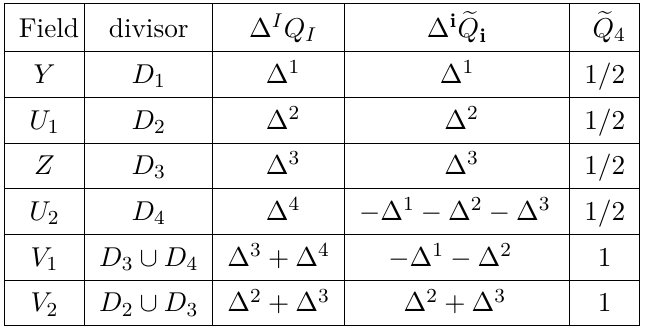
Table 1 . Charge assignments for the L a,b,c family of toric quivers. These have d = 4 global symmetries, and include the Y p,q family (given by Y p,q = L p + q,p − q,p ), which in turn includes Z 2 p orbifolds of N = 4 SYM (given by Y p,p ), as well as the conifold theory and its Z p orbifolds (given by Y p, 0 ). The table displays the six different types of fields, where we are using the notation of [52]; the divisors in the Calabi-Yau cone that determine the charges of the composite fields in terms of the first four, basic types; the values of the charges Q I , I = 1 , . . . , 4 , through the combination ∆ I Q I ; the flavor charges e Q i , i = 1 , . . . , 3 , through the combination ∆ i e Q i ; the R-charge e Q 4 . The charges e Q I are obtained from the Q I chosen here via the transformation (5.4), and coincide with those appearing in